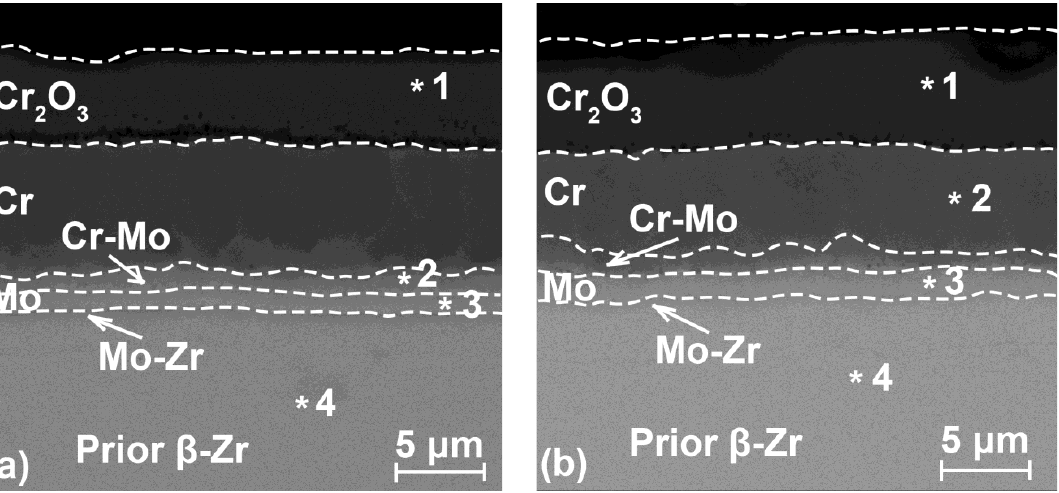
Figure 7. Cross-section SEM images of the Cr/Mo-coated Zr alloy samples after steam oxidation at 1200 °C for 1000 s ( a ) and 2000 s ( b ). Table 5. The outer view and weight gain (in mg/cm 2 ) of the samples after oxidation at 1400 °C. Oxidation Time Point Cr, at.% O, at.% Zr, at.% Mo, at.%